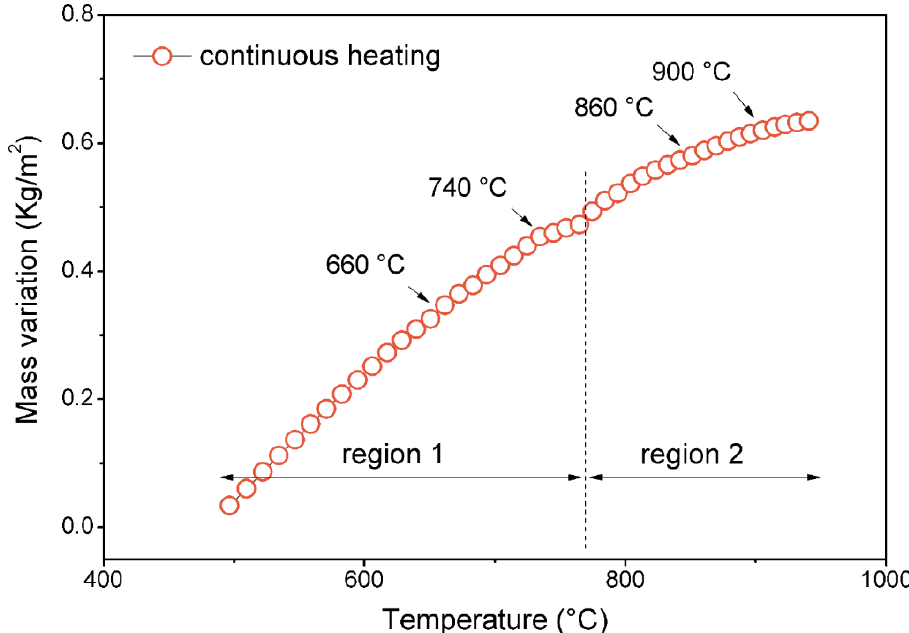
Metals 2022 , 12 , x FOR PEER REVIEW Figure 4. Mass variation per unit surface area as a function of the temperature for the Ni-based alloy.